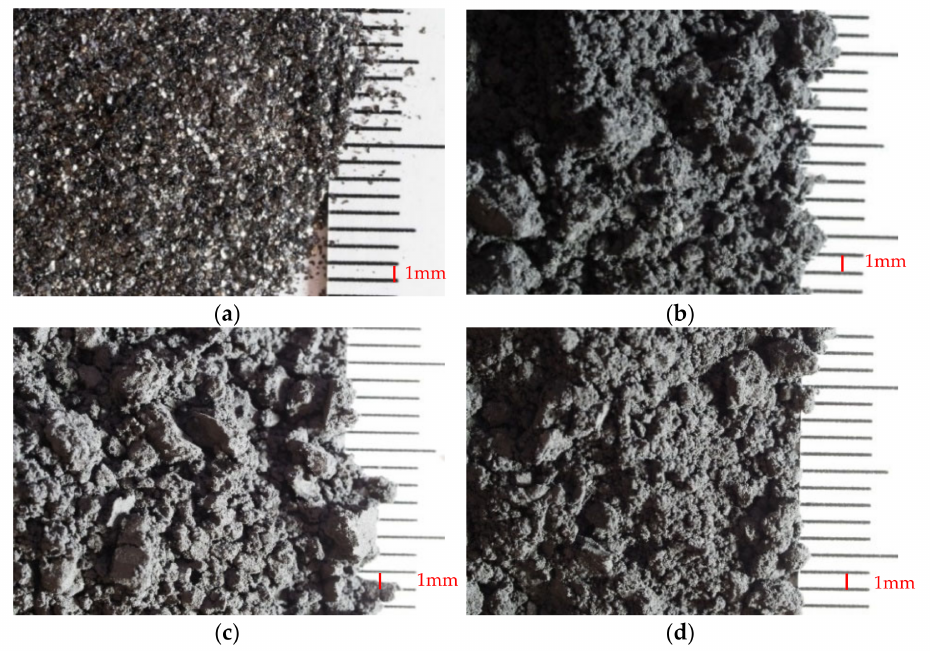
Figure 1. Structure of conductive fillers: ( a ) Supragraphite C300; ( b ) Micrographite UC4; ( c ) Micro- graphite C4; ( d ) Condufit